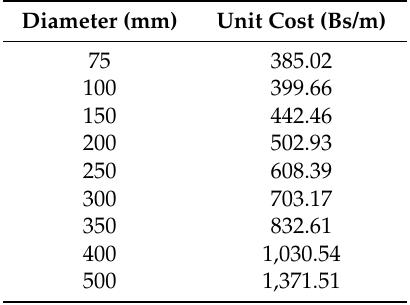
Table 2. Unit costs for replacing pipes as a function of